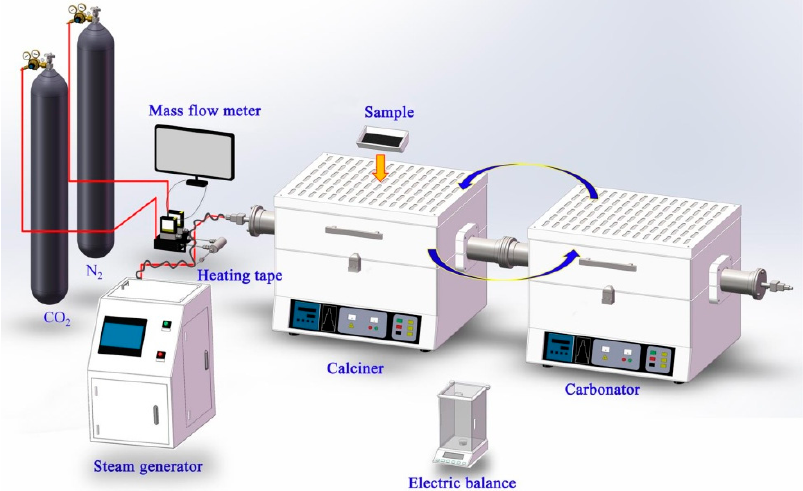
Figure 1. Diagram of dual fixed-bed reactor (DFBR) with steam generator.